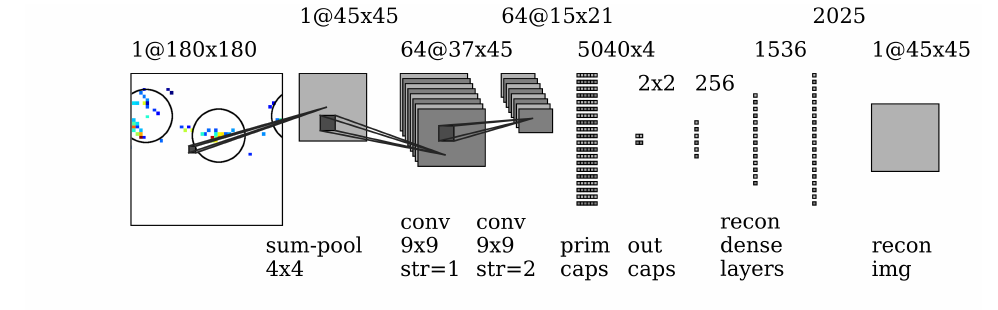
Figure 9: Simplified Capsule architecture.